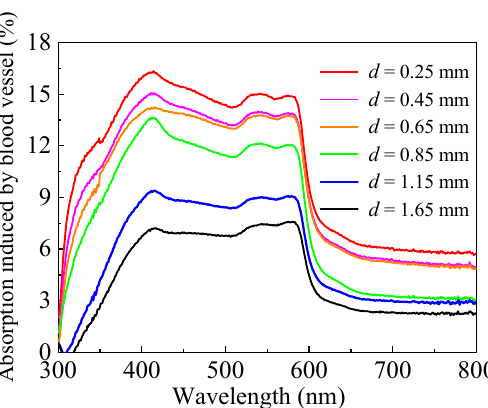
Figure 12. Vessel depth-related spectral signal.